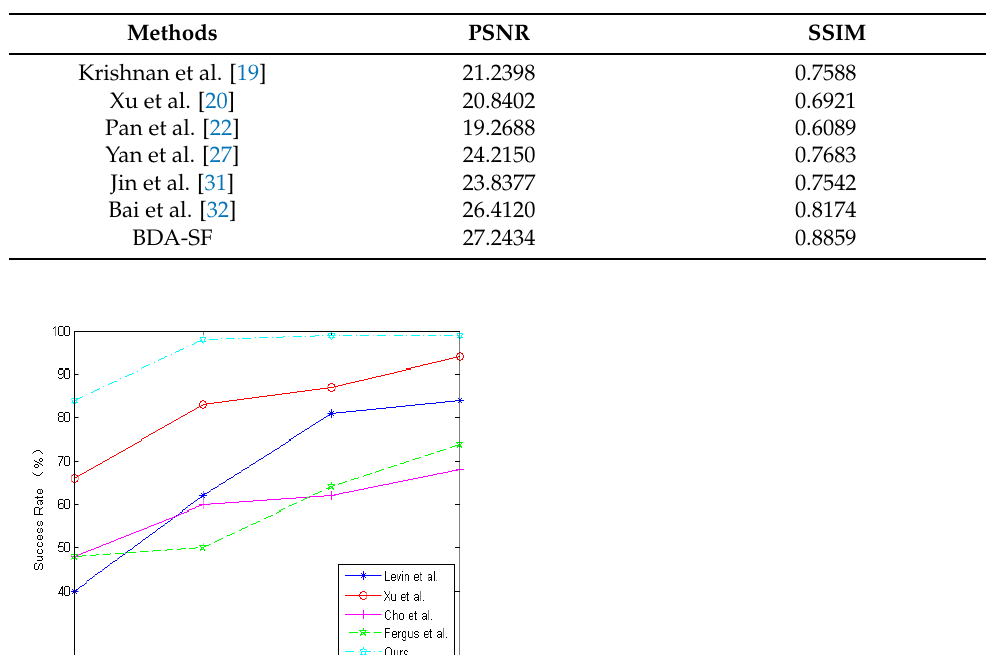
Figure 10. Deblurred results from the dataset [18]. The PSNR and SSIM values are shown in Table 1. BDA-SF has the highest PSNR and SSIM. (Best viewed on high-resolution display with zoom-in). Table 1. Quantitative evaluations on the image from Figure 10.